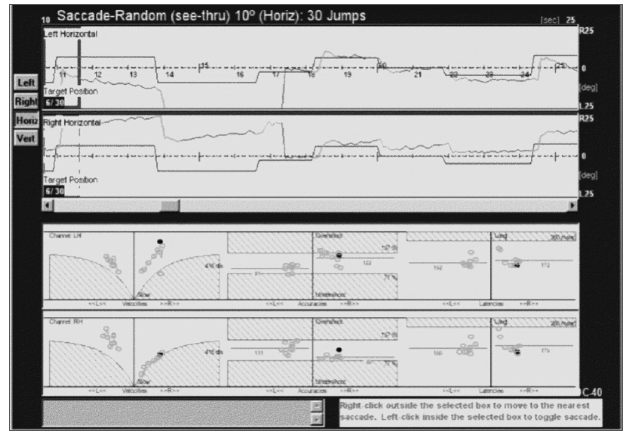
Figura 3. Sacádico de indivíduo com síndrome cerebelar